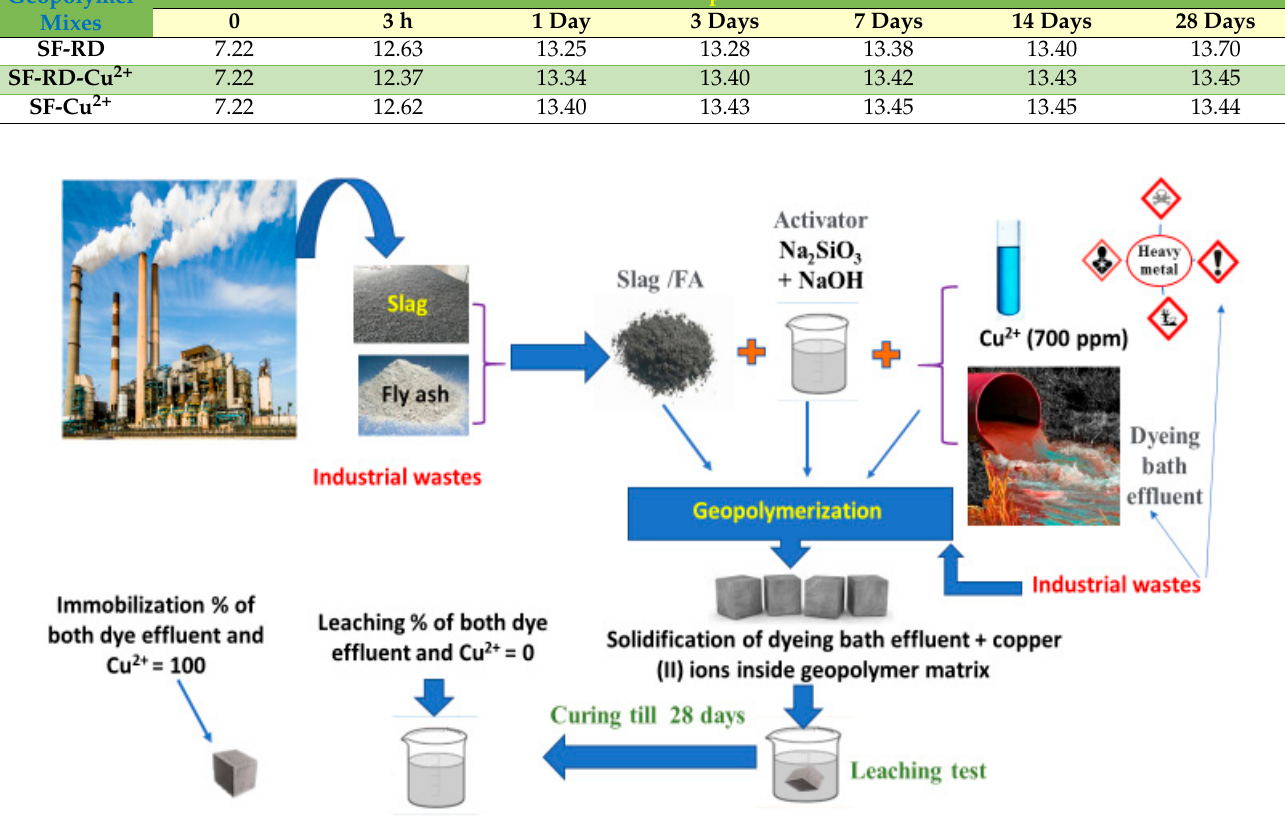
Figure 10. Schematic of environmentally friendly disposal of industrial wastes by using a geopolymerization strategy.